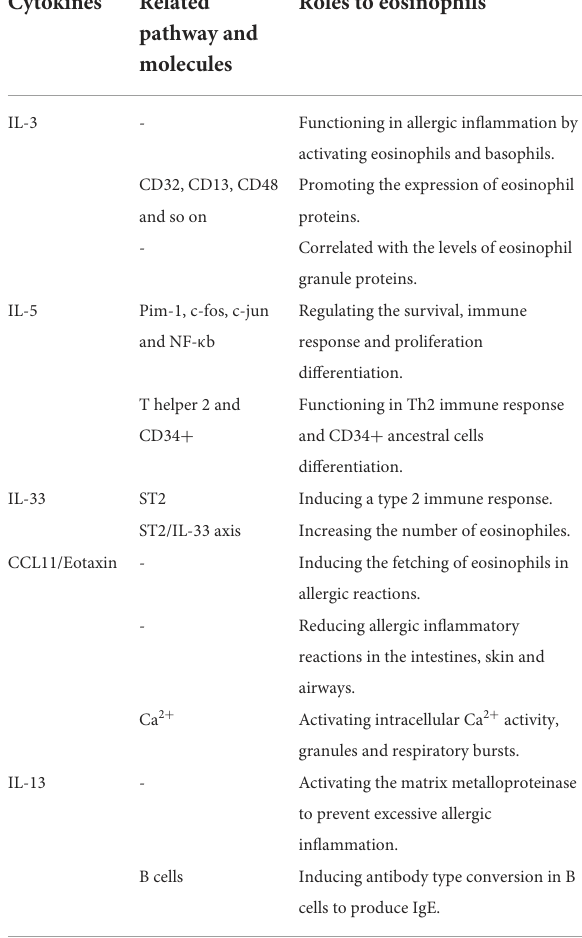
TABLE 1 Eosinophils-related cytokines and their